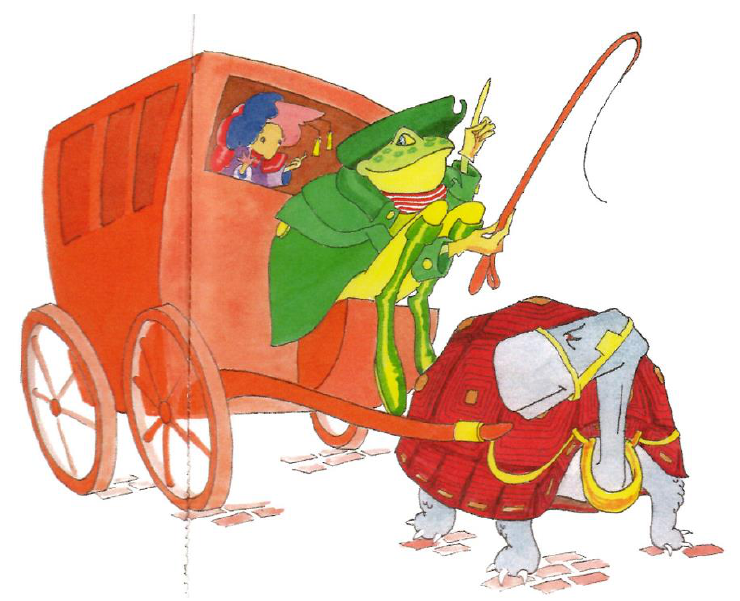
Figure 4. McMaster’s illustration for The Beautifull Cassandra (Austen 2021), p. 13.